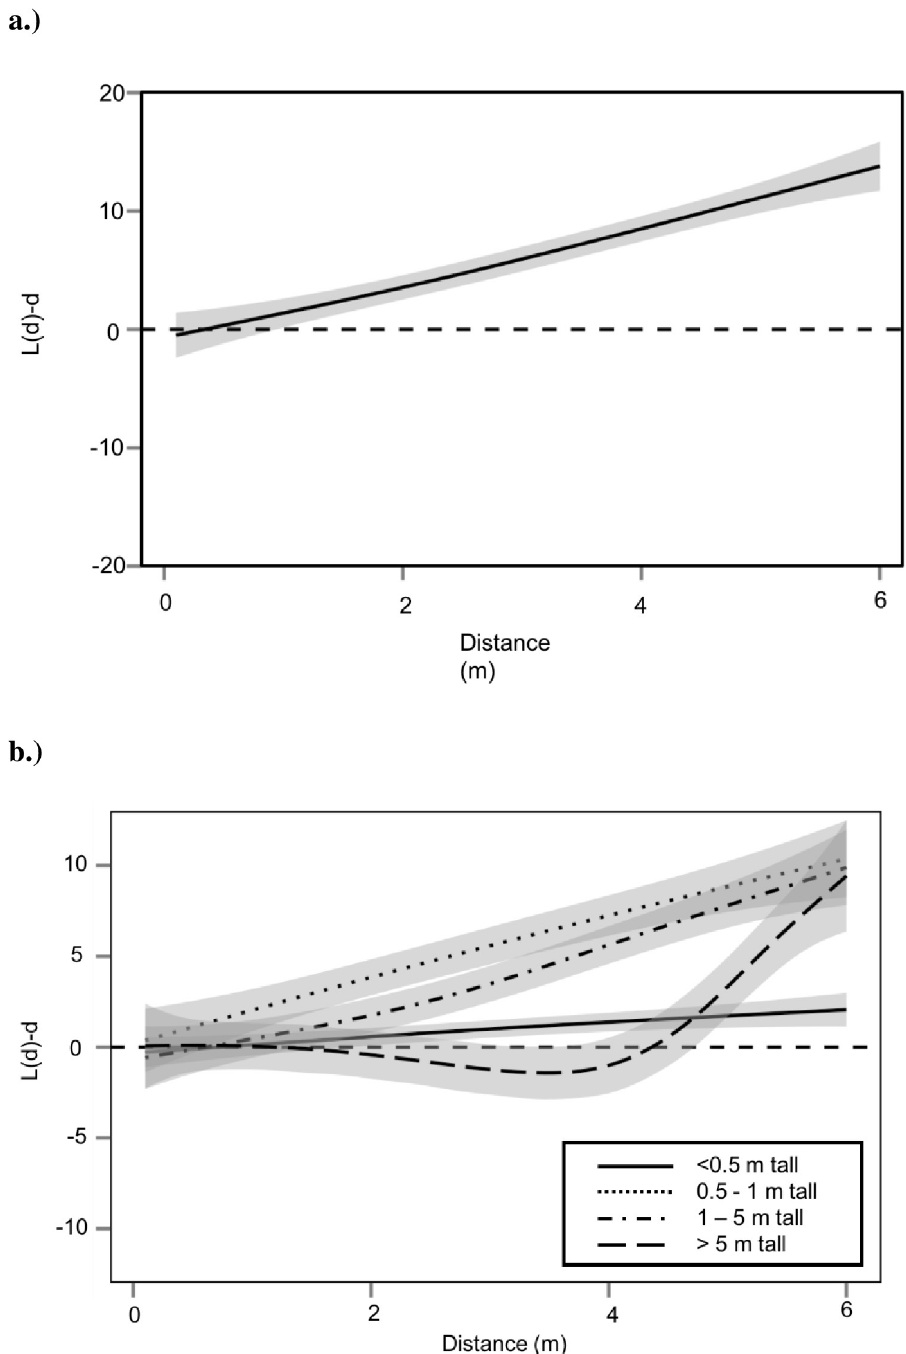
Fig 2. Pooled Besag’s L statistic across distance from spatial point pattern analysis for the full community of woody plants > 10 cm in height at Powdermill Nature Reserve in Southwestern Pennsylvania. a.) The community of woody plants (all species, n = 62 point patterns) was significantly overdispersed regardless of dispersal mechanism. However, the L(d)-d for the community remains positive across all distances indicating that some individuals occur close to members of their own species. b.) Individuals that were < 0.5 m tall were the least overdispersed (n = 25 point patterns). Individuals that were intermediate in height (0.5m to 5 m tall) were significantly more overdispersed than smaller individuals, though not significantly more or less overdispersed than the largest individuals (n 0.5-1m = 26 point patterns, n 1-5m = 27 point patterns). The largest individuals ( > 5m tall, n = 13 point patterns) were not significantly more overdispersed than individuals that were 0.5m to 5m tall; however, the drop in the line below complete